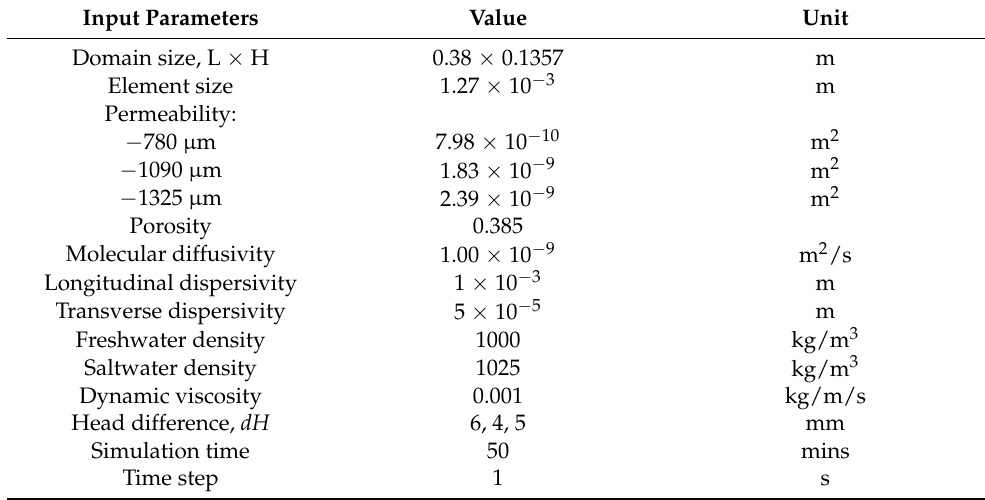
Table 1. SUTRA simulation input